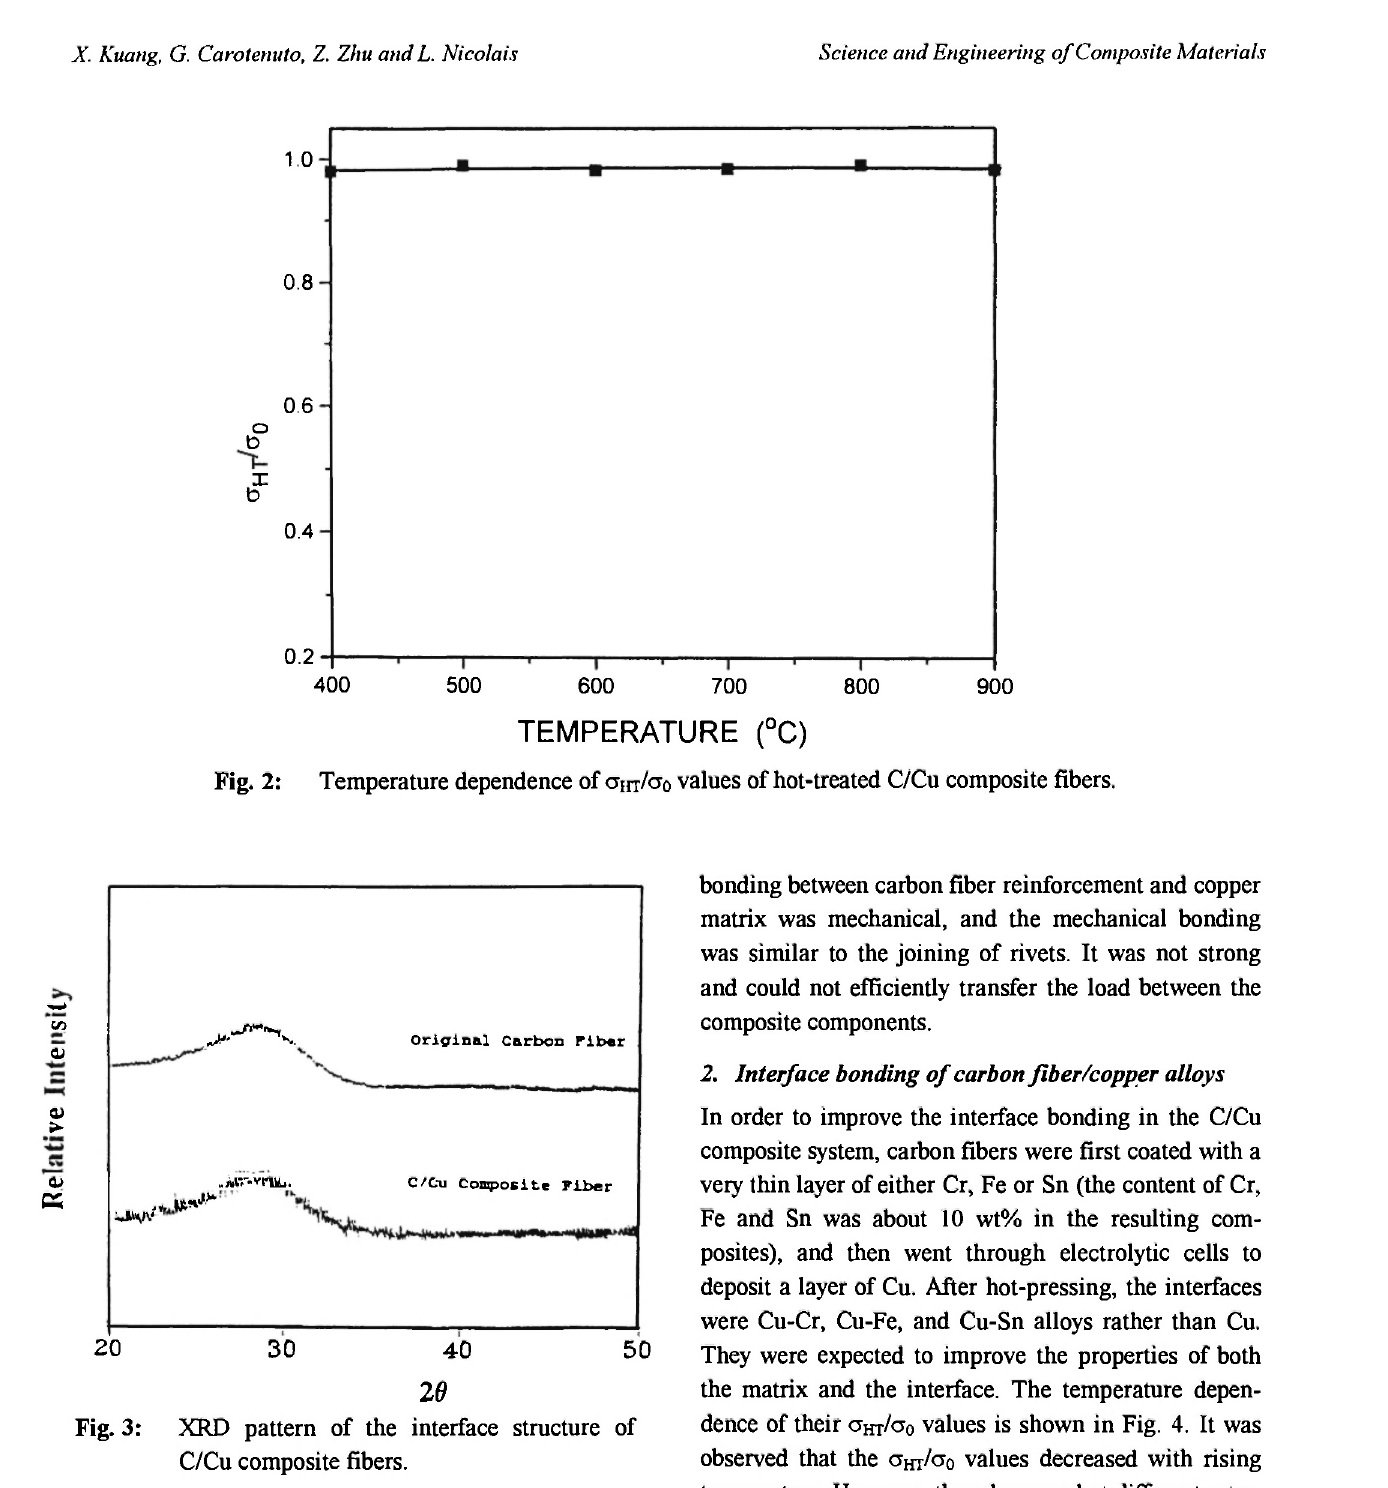
Fig. 3: XRD pattern of the interface structure of C/Cu composite